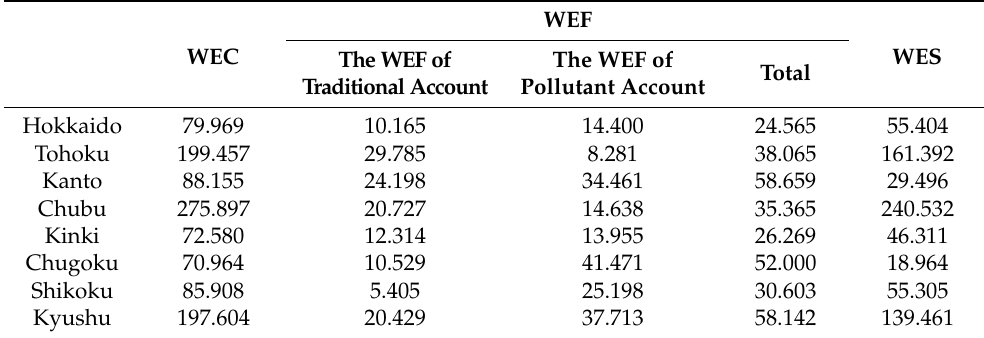
Table 3. The total WEF, WEC, and WES of different regions in 2020 (Unit: 1 M gha). WEF WEC WESThe WEF of The WEF of Traditional Account Pollutant Account